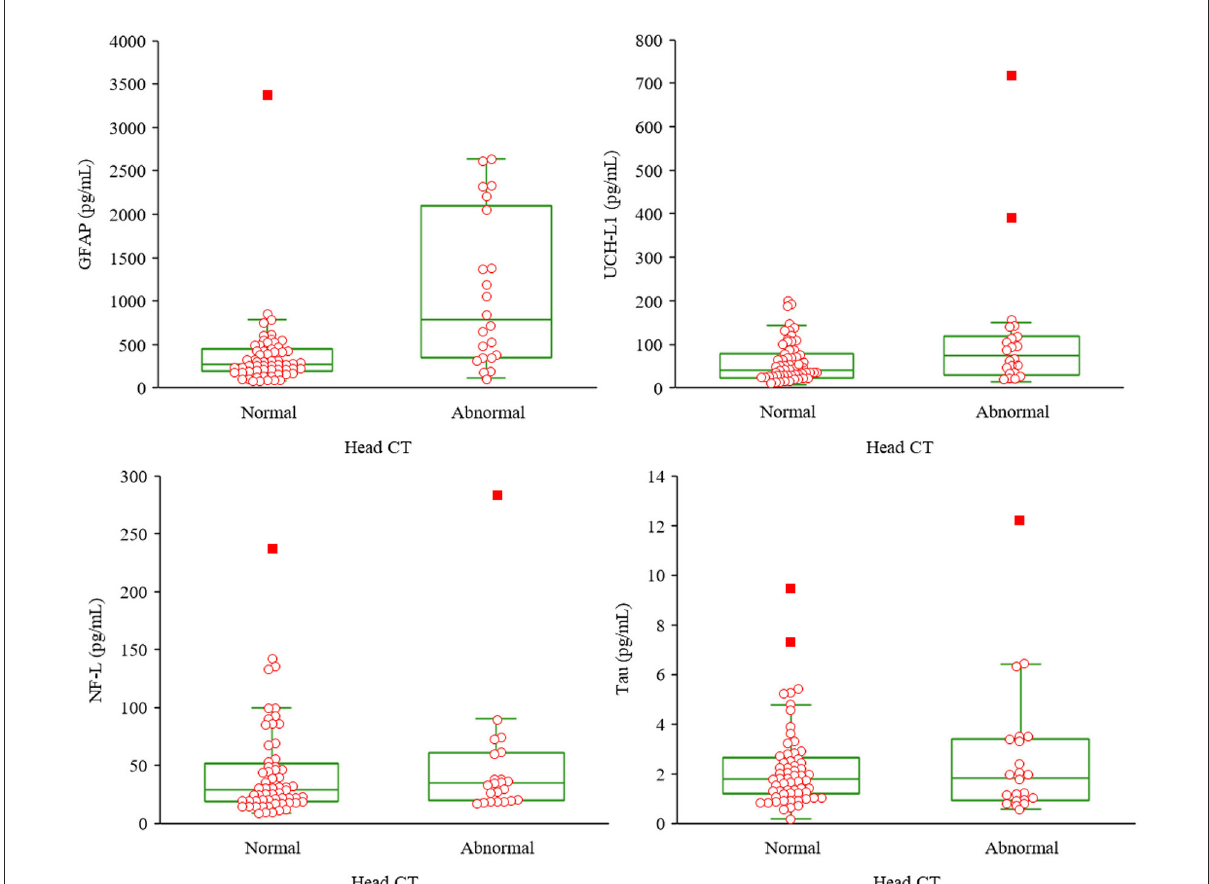
FIGURE2 Box and whisker plots for the biomarkers by group. Upper left, glial fibrillary acidic protein; upper right, ubiquitin C-terminal hydrolase-L1; lower left, neurofilament light; lower right, total tau; CT; computed tomography. Normal head CT n = 61, abnormal head CT n =